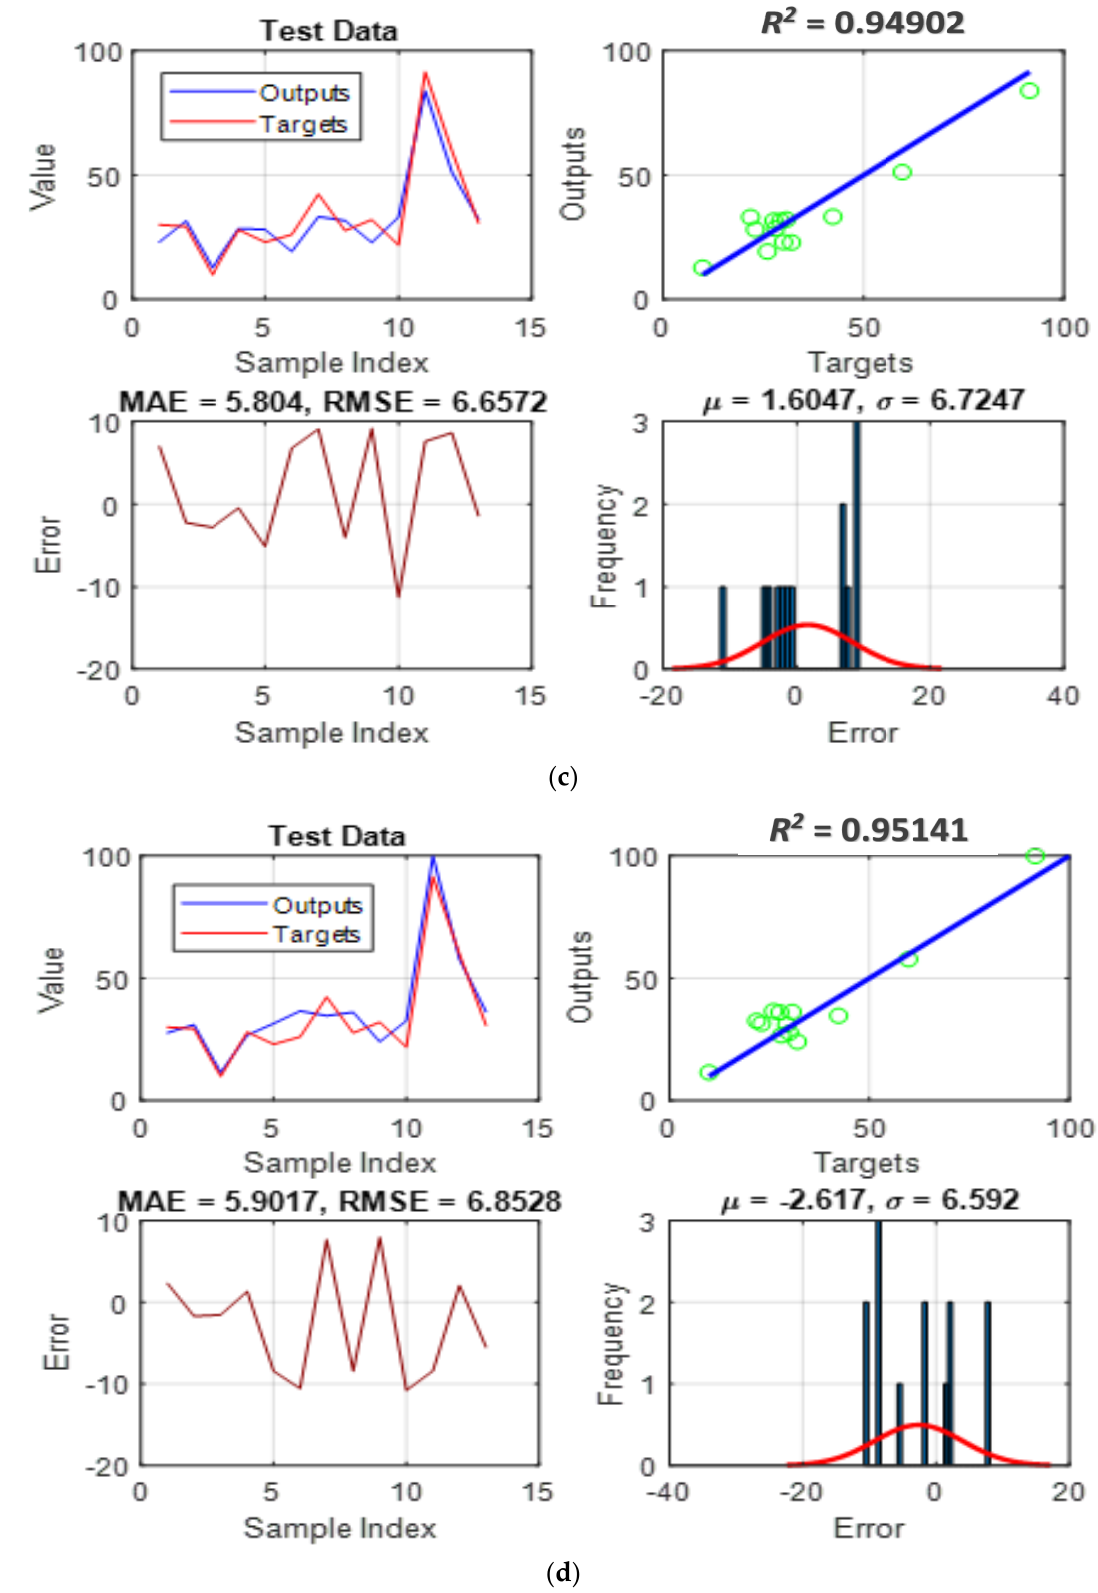
Figure 6. Testing results of the ( a ) HHO – ANFIS, ( b ) SSA – ANFIS, ( c ) TLBO – ANFIS, and ( d ) WCA – ANFIS.